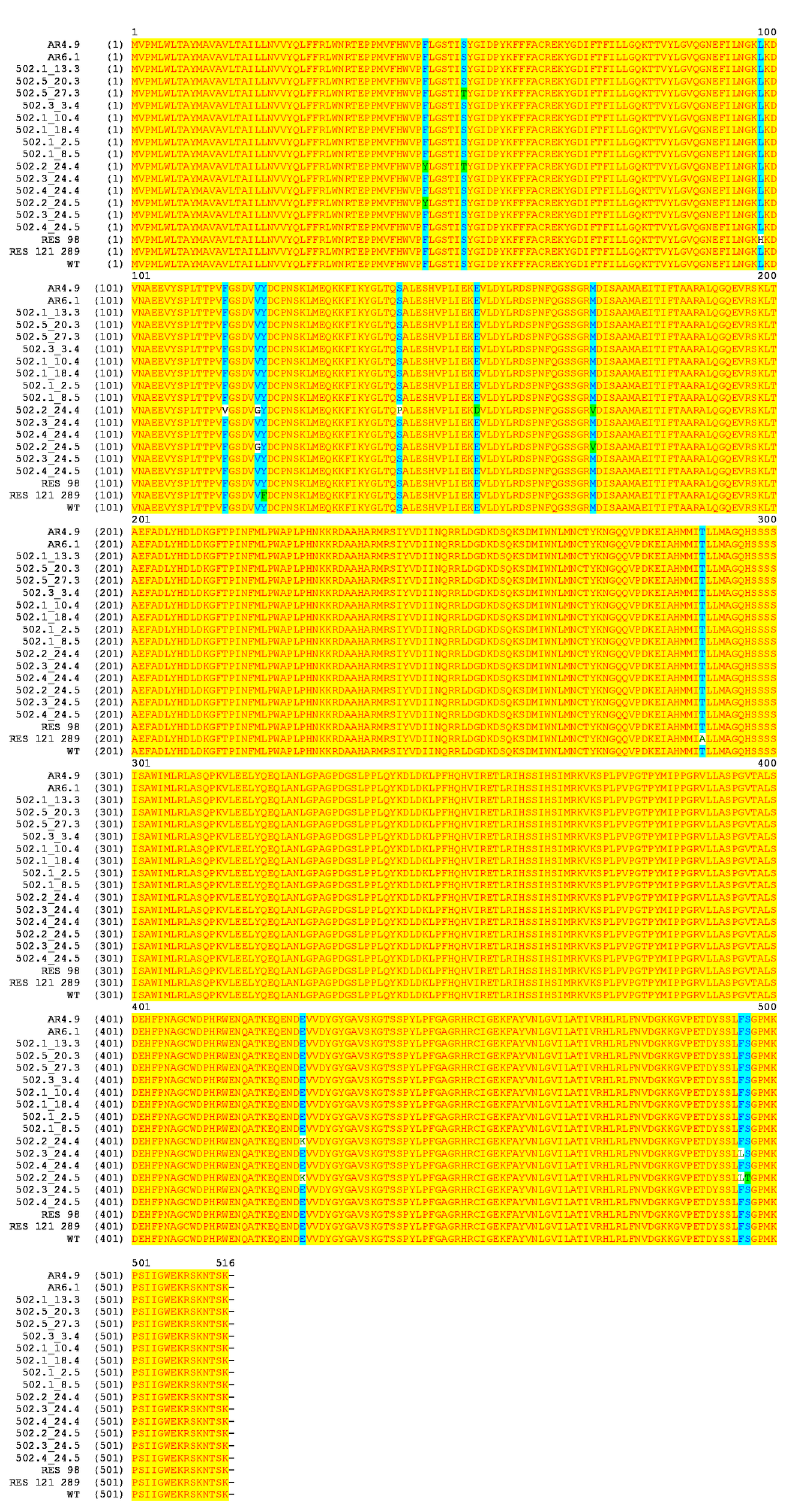
Fig 4. Cyp51A amino acid sequence multiple alignment of 14 isolates of A . fumigatus from orange-based compost and 2 isolates from oranges. Two reference DMI resistant isolates (L98H, and Y121F+T289A) and wild-type reference (WT) are included in analysis. Background amino acid colour: yellow = identical amino acids; blue = conservative amino acids; green = block of similar amino acids; white = non similar amino acids.